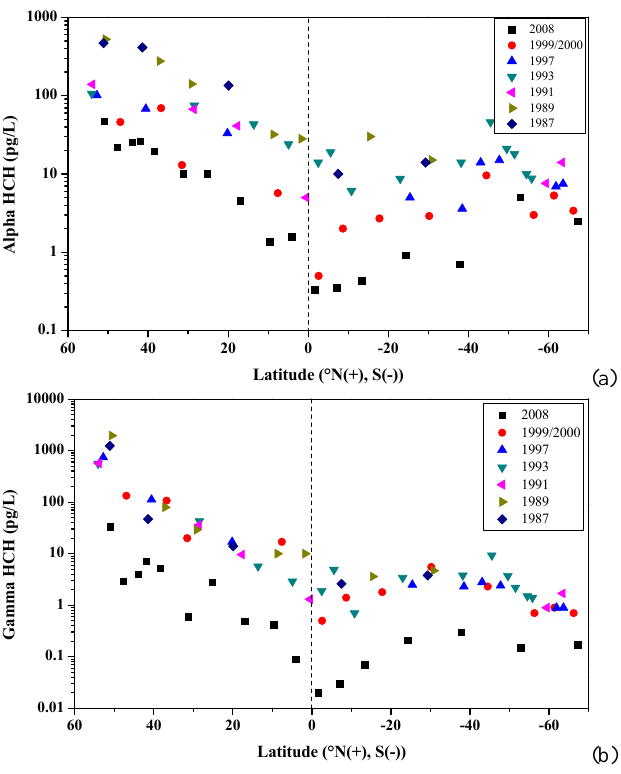
(b) Fig. 4. Temporal and latitudinal variation of α -/ γ -HCH ratio (a) in the Atlantic and the Southern Ocean measured during cruise ANT-V (1987), ANT-VII (1989), ANT-X (1991), ANT-XI (1993), ANT-XV (1997), ANT-XVII (1999/2000) and ANT-XXV (2008, this work), and the latitudinal variation of α -/ β -HCH ratio (b) obtained in this work (2008). α -/ γ -HCH and α -/ β -HCH and ratios in technical mix- tures are highlighted in